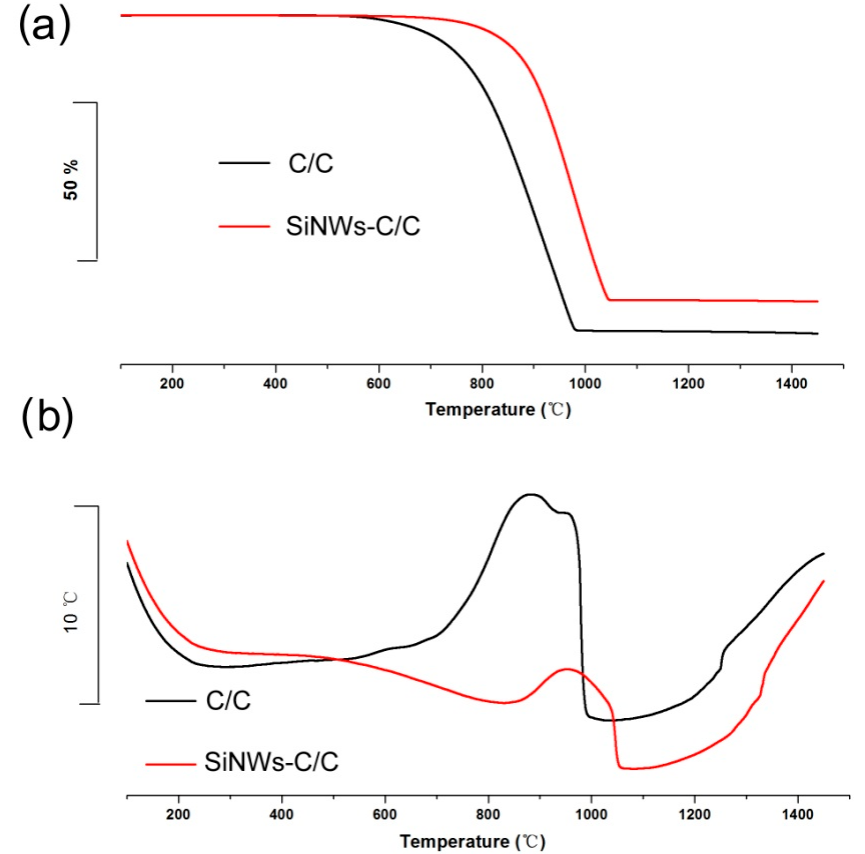
Figure 5. TGA (thermo-gravimetric analysis) ( a ) and SDTA (synchronous differential thermal analysis) ( b ) curves of the C/C and SiCNW-C/C composite samples.